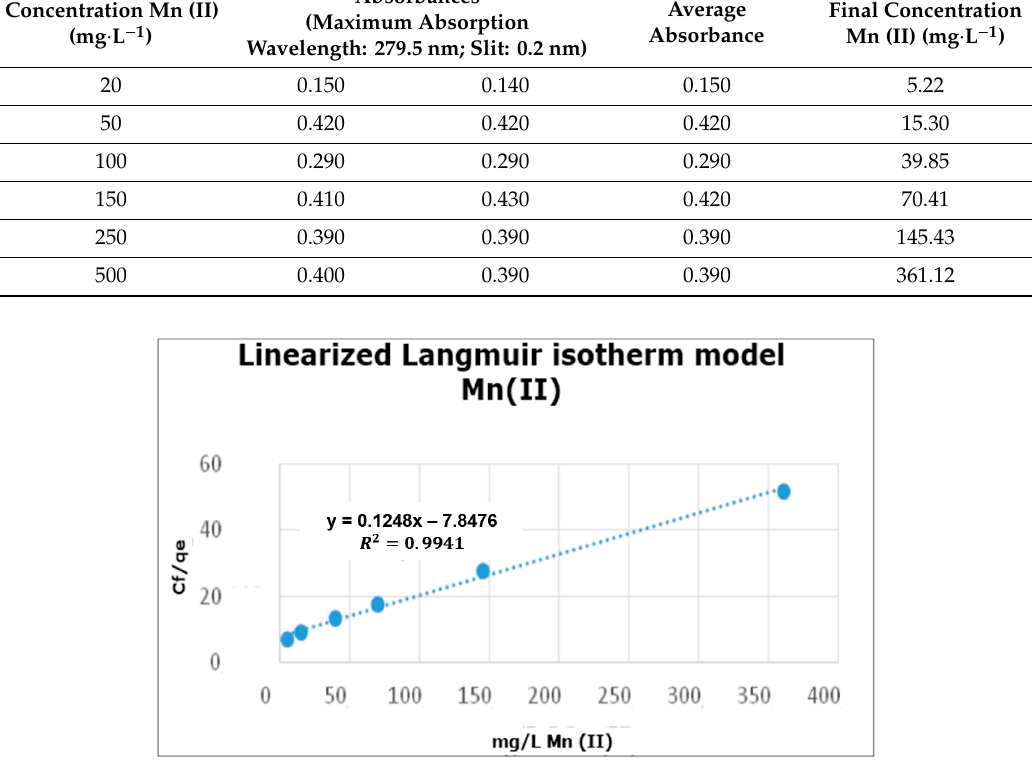
Figure 5. Linearized Langmuir isotherm model for the Mn (II) bioadsorption process with the CP.